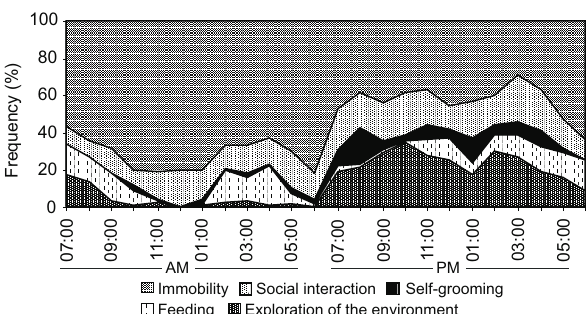
Figure 1. Trichodactylus panoplus : Diel pattern of activity under laboratory conditions.